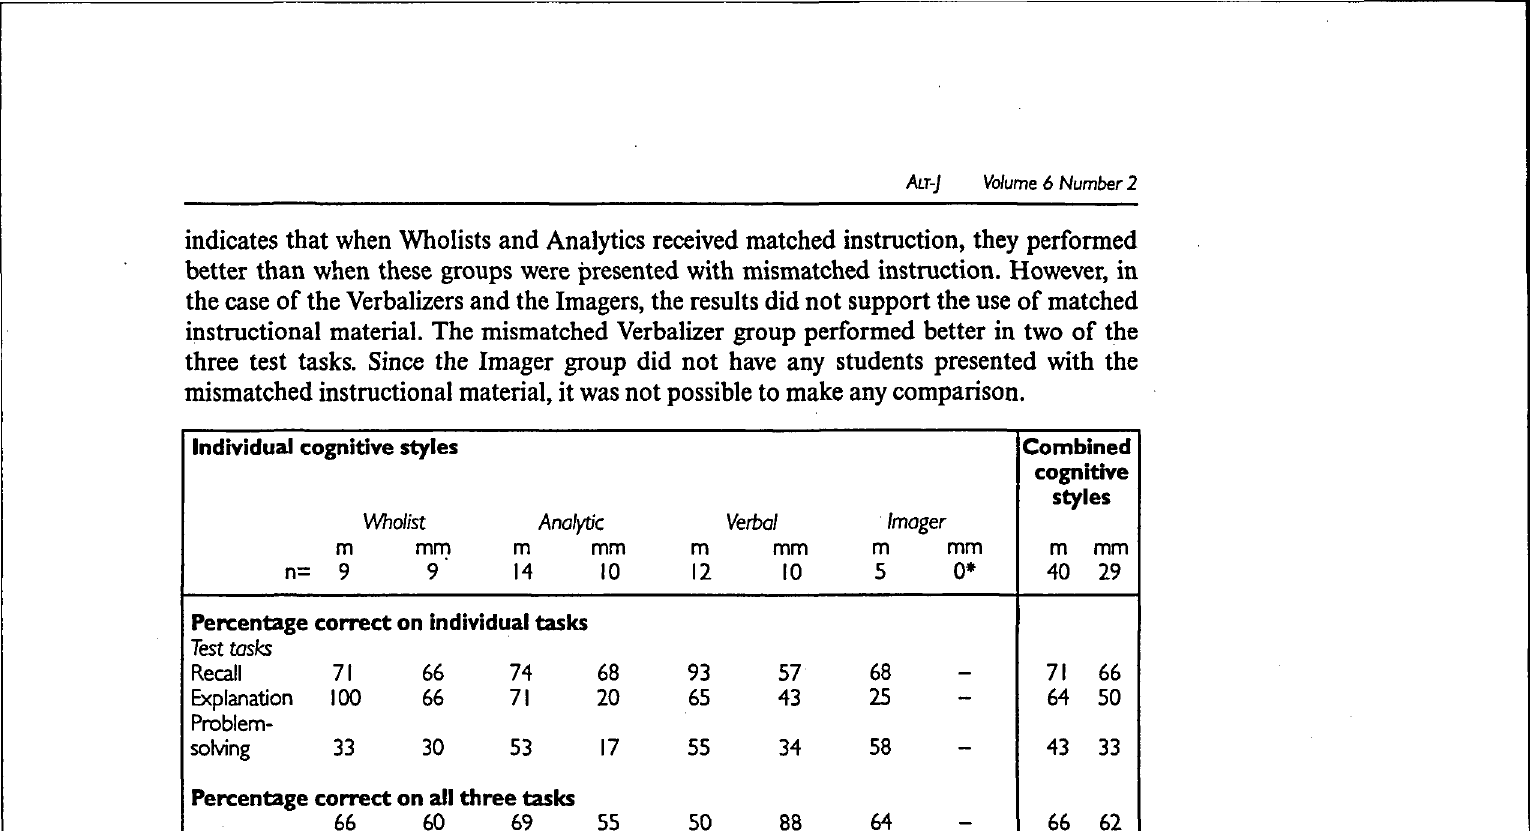
Table I: Comparison of matched and mismatched instructional formats on performance by test tasks and by cognitive styles (m = matched; mm =